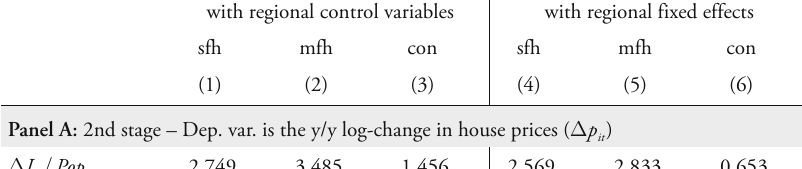
Table 3: IV Regressions for the y (cid:12) y Log-Change in House Prices ( (cid:27) p with regional control variables with regional fixed